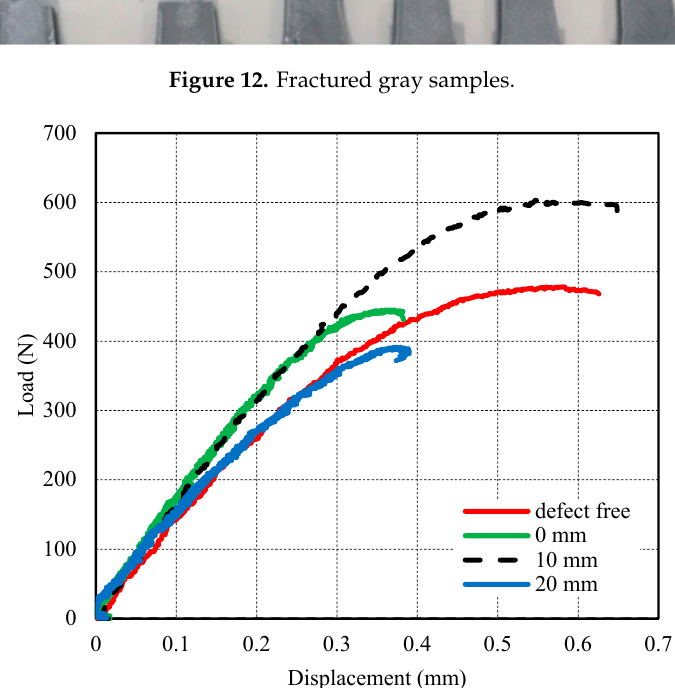
Figure 13. Load-displacement curves for the white set specimens with a defect at different locations from the sample center.